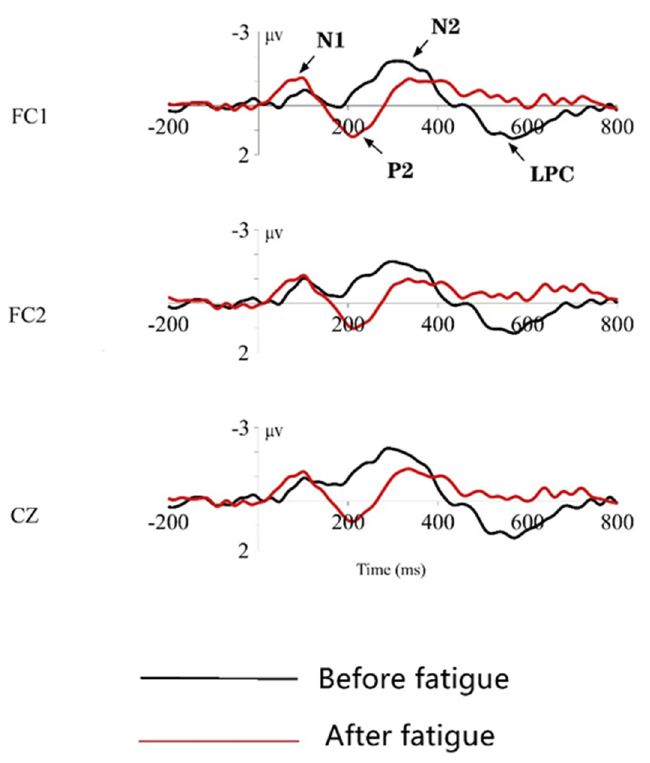
Figure 14. Total mean ERP plots/diagrams at the FC1, FC2, and CZ electrodes. Table 12. Paired-sample test for mean wave amplitudes of N1, N2, P2, N2, and LPC, before and after brain fatigue. Paired Differences Std.Deviation